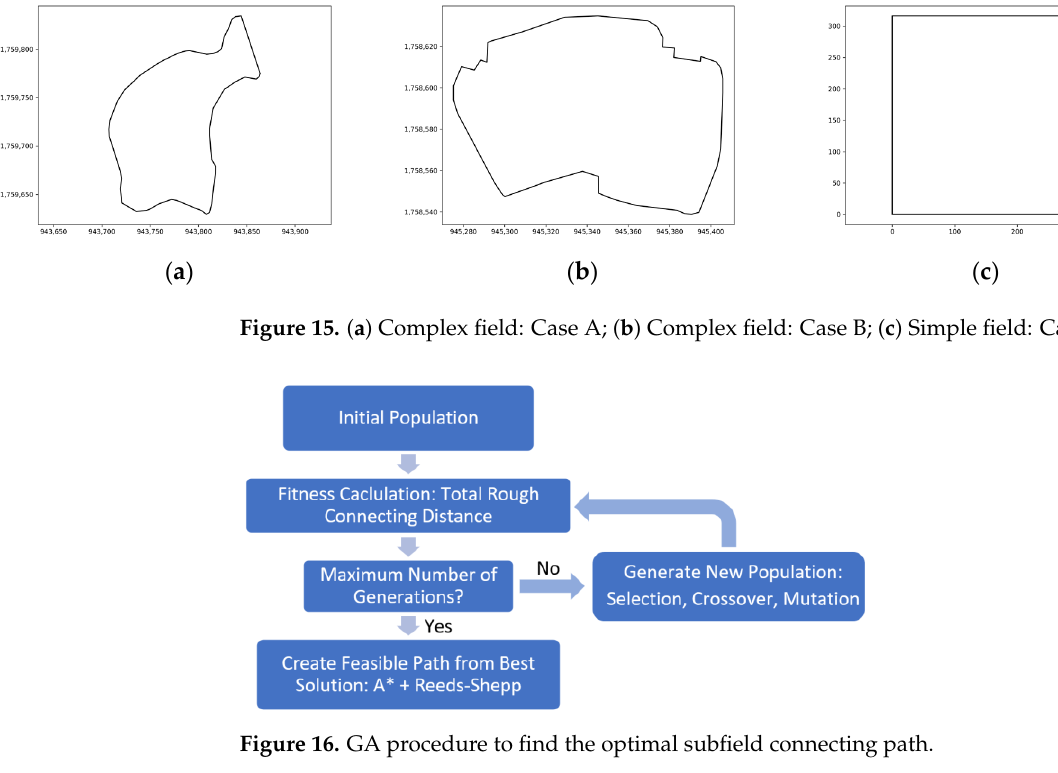
Figure 15. GA procedure to find the optimal subfield connecting path.